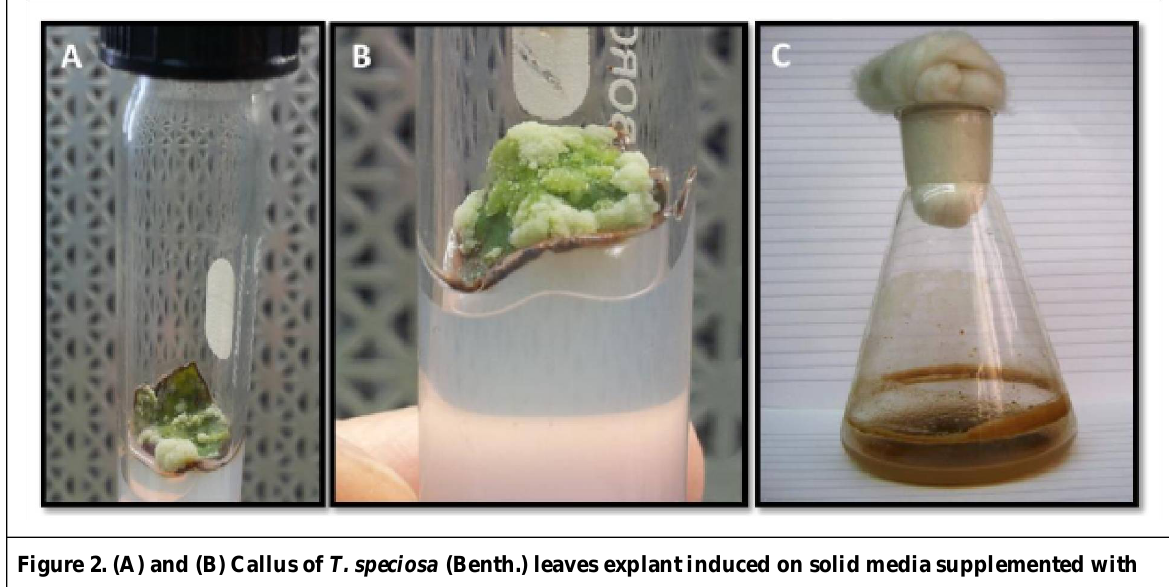
Figure 2. (A) and (B) Callus of T. speciosa (Benth.) leaves explant induced on solid media supplemented with 2, 4-D (1 ppm). The callus appeared after four weeks approximately. (C) Suspension culture in liquid MS medium supplemented with BA (1 ppm).